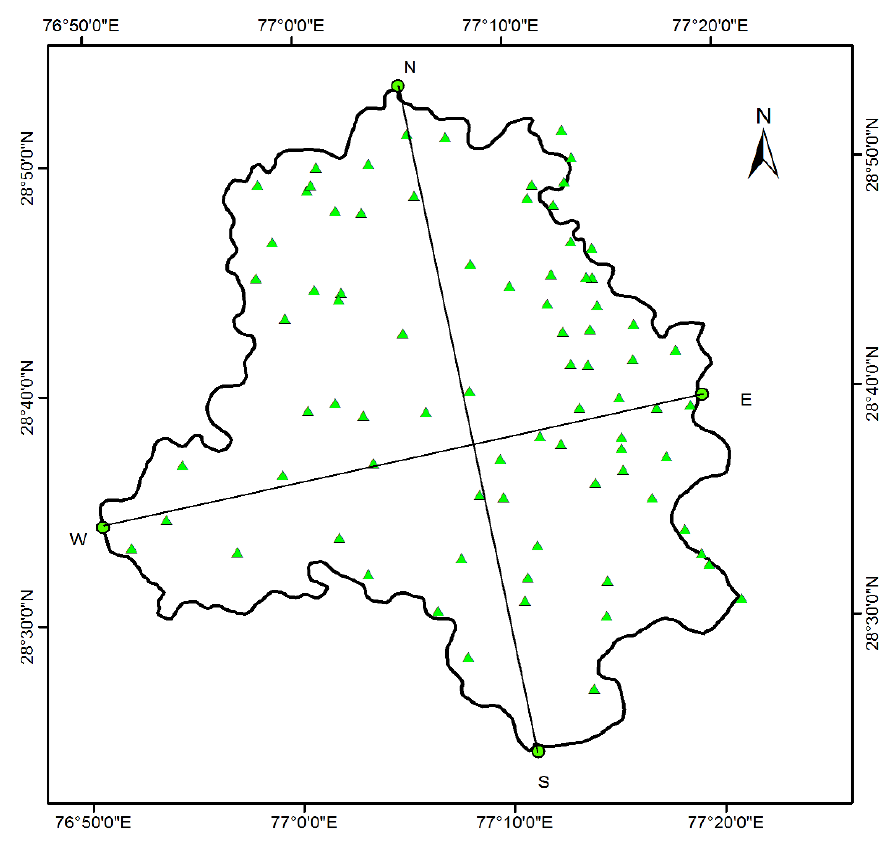
Figure 3. Location of sample sites and profile lines (north-south and west-east) for comparison of surface temperatures in different